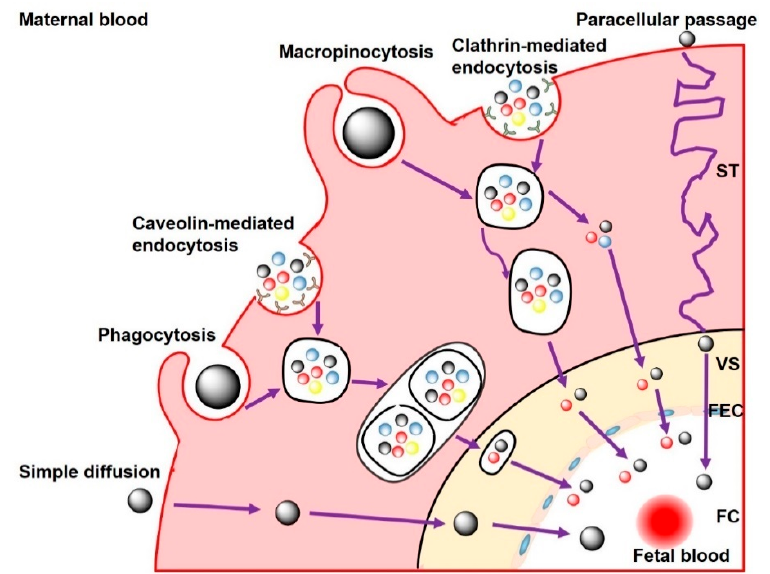
Figure 3. Scheme showing the transplacental transport of NPs. NPs cross the blood–placental bar- rier by paracellular passage and transcellular passage. Very small NPs can cross syncytiotrophoblasts (STs) through placental channels, and enter villous stroma (VS). Diffusion may then occur through the fetal endothelial cells (FECs) into the lumen of the fetal capillaries (FCs). NPs may also be taken up by STs via phagocytosis, clathrin-/caveolae-mediated endocytosis, and macropinocytosis, and eventually enter the fetal blood.